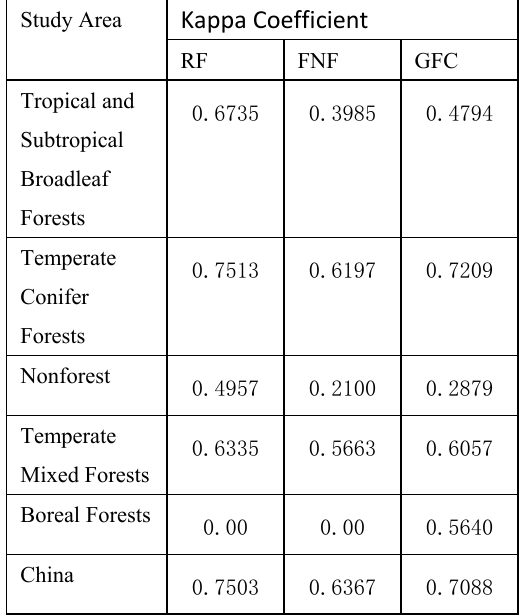
Table 4. The kappa coefficients of the